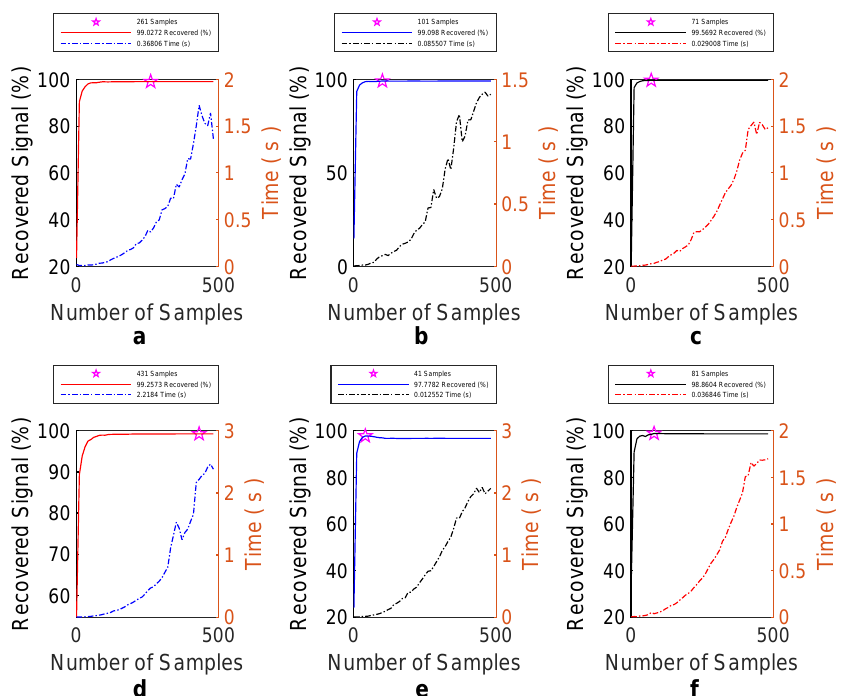
Figure 8. Calculation of the number of k atoms vs. processing time (( a – c ) current and ( d – f ) voltage at bus 4).